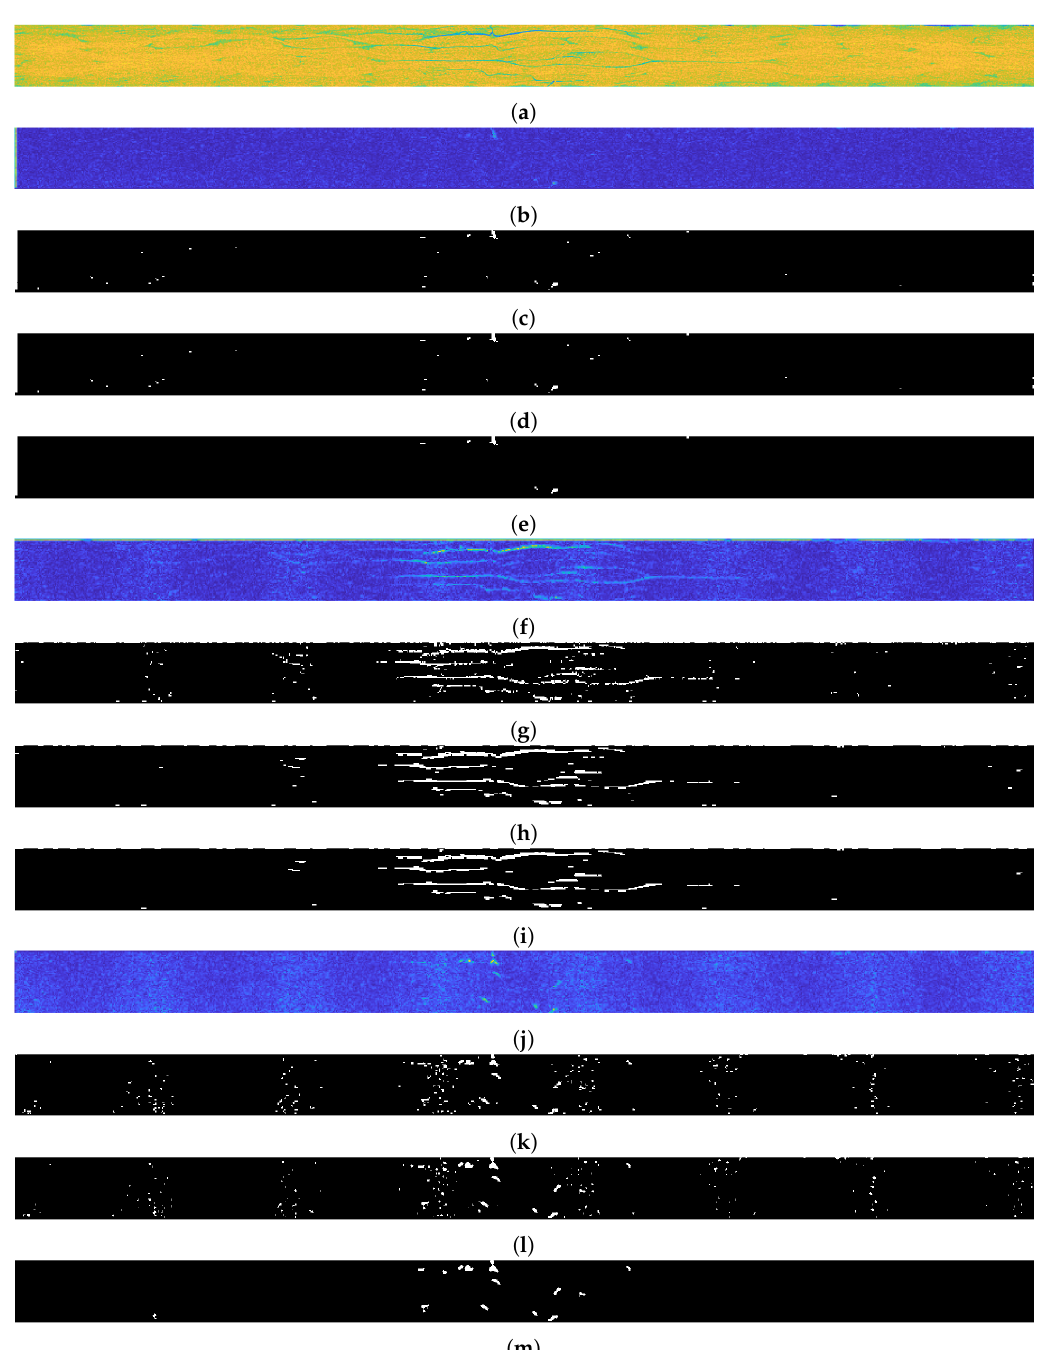
Figure 9. The original slice ( a ) and the results of WT and post-processing—slice 84: ( b – e ) vertical; ( f – i ) horizontal; ( j – m )